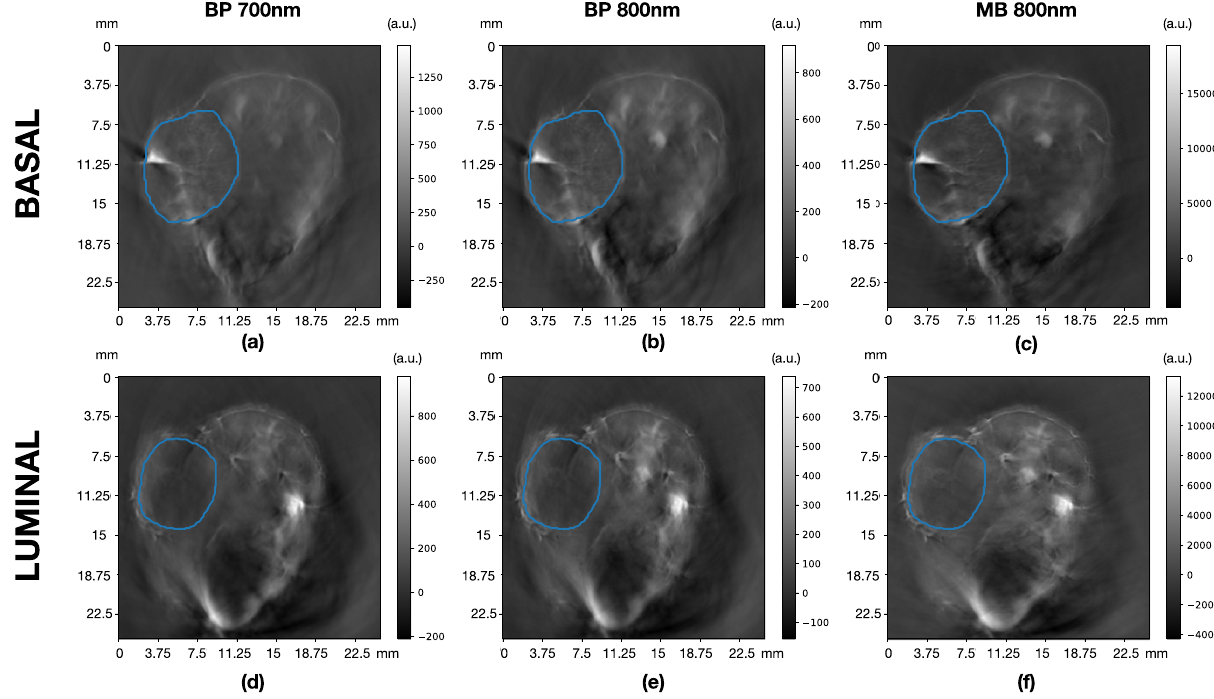
Figure 1. Example 2D photoacoustic images illustrating the volume of interest segmentation performed for one basal PDX ( a – c ) and luminal B PDX ( d – f ). For each case, images are shown for backprojection (BP) reconstruction, using 700 nm ( a , d ) and 800 nm ( b , e ) wavelengths, as well as for model-based (MB) reconstruction using 800 nm ( c , f ).